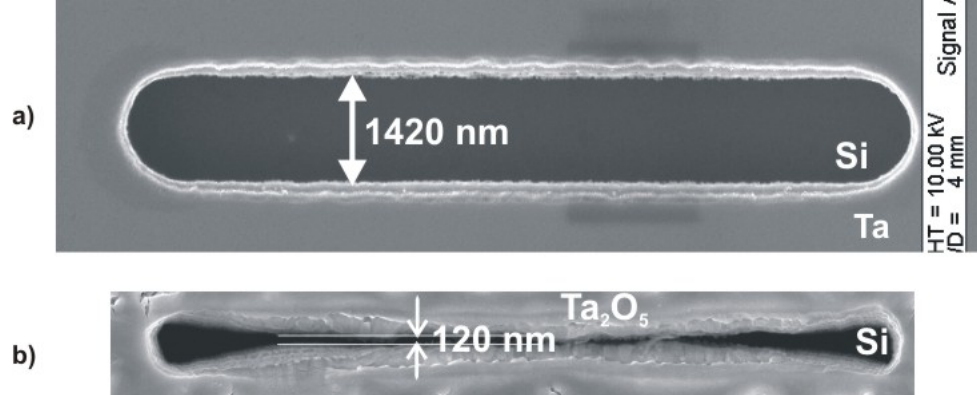
Figure 4. Scanning electron microscopy picture of a prepared “fluidic-channel”-type structure before (a) and after (b) Ta oxidation. A pattern-size reduction of about 1300 nm or by a factor of about 12 has been achieved.